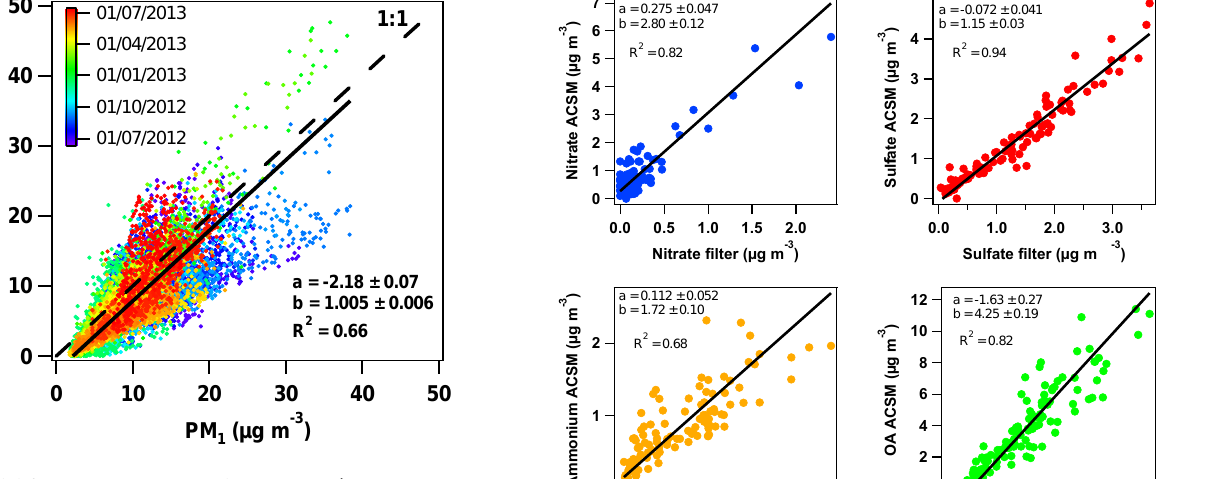
Figure 1. ACSM components + BC concentrations vs. PM 1 mea- sured by the optical counter, coloured according to the sampling time (dd/mm/yyyy). Line and parameters correspond to least or- thogonal distance fit ( y = a + bx ). The wild fire period is excluded from the fit. Figure 2. ACSM component concentrations vs. 24h samples con-